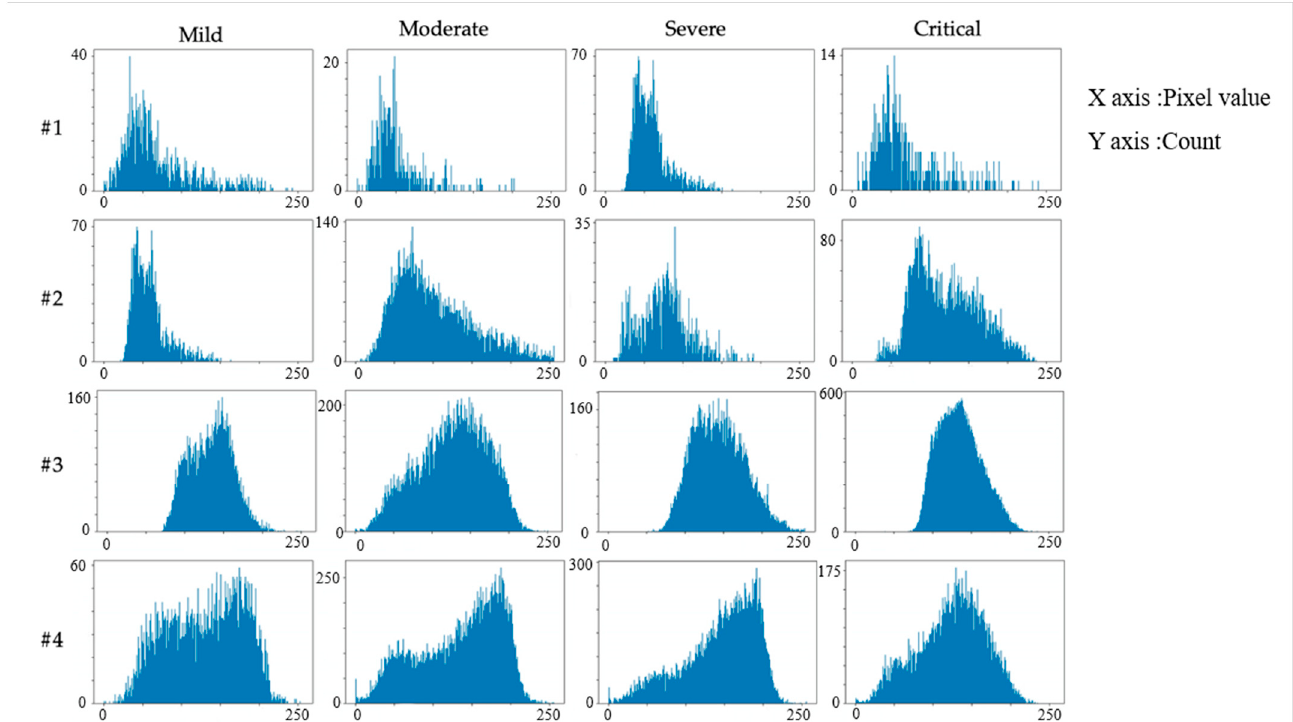
Figure 2. The comparison of the grayscale histograms of four CT images (lesions) from different severity grades.